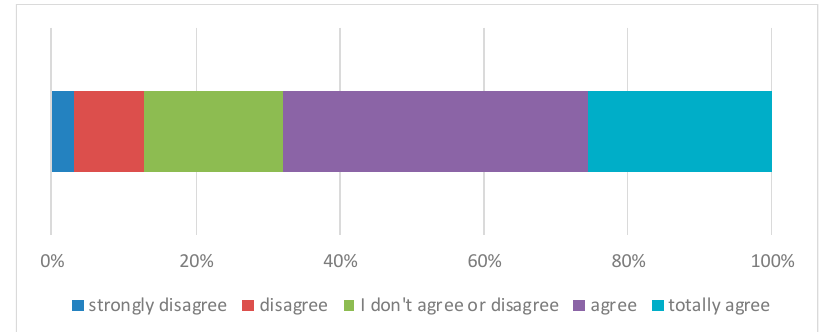
Figure 8. Degree of knowledge of mathematics that the calculus teacher assumes that the student has with respect to the reality.